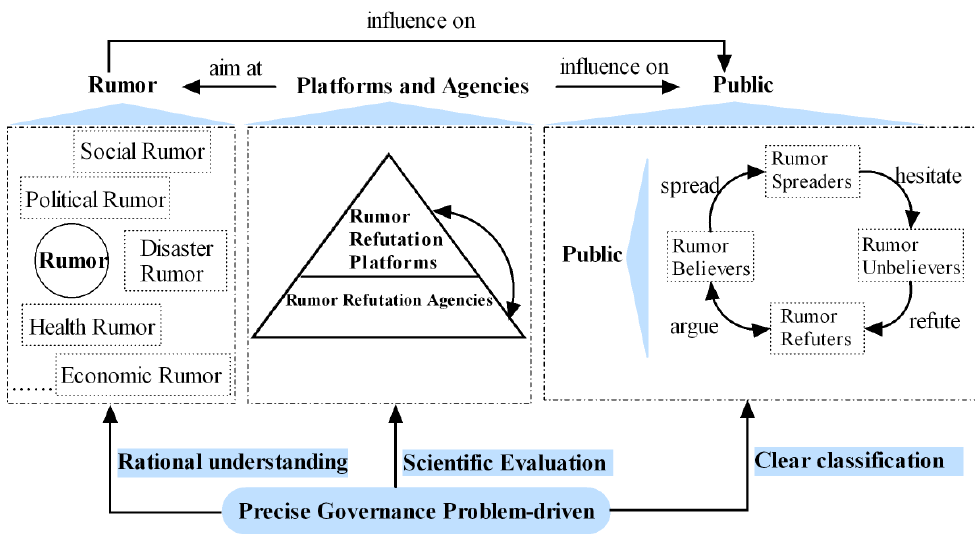
Figure 6. The Framework of Social Media Rumor Precise Governance System .